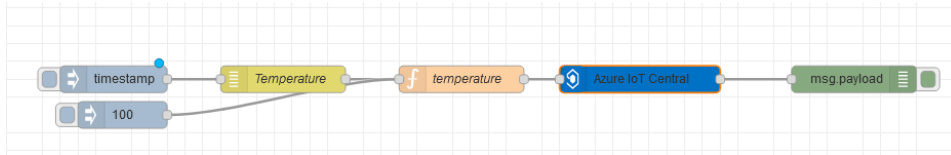
Figure 15. Node-RED data sending flow (air temperature).